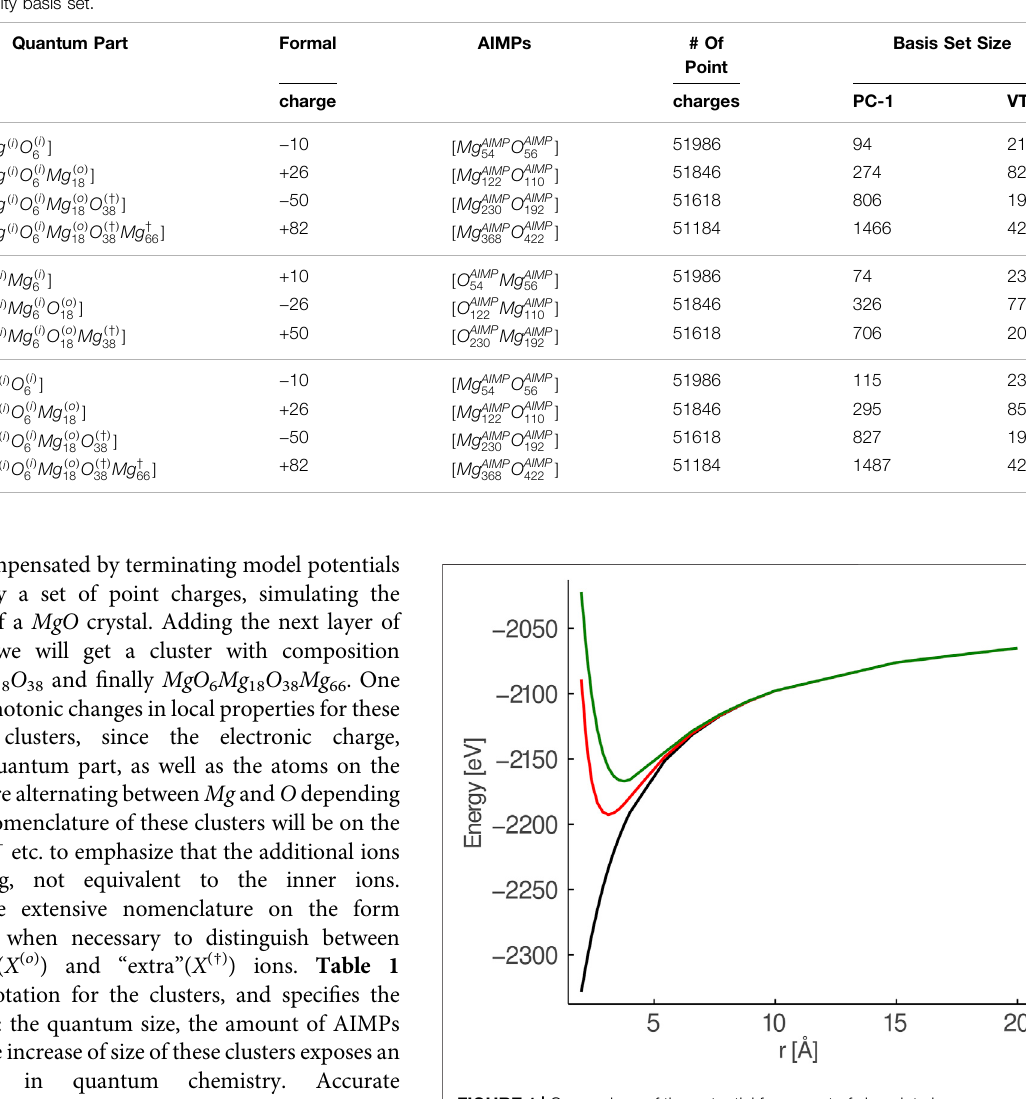
FIGURE 1 | Comparison of the potential from a set of six point charges (black), six Mg 2+ -AIMPs (red) and six Ca 2+ -AIMPs (green) surrounding a O 2 − - ion. The surrounding charges/AIMPs are placed in an octahedral fi eld and stretched